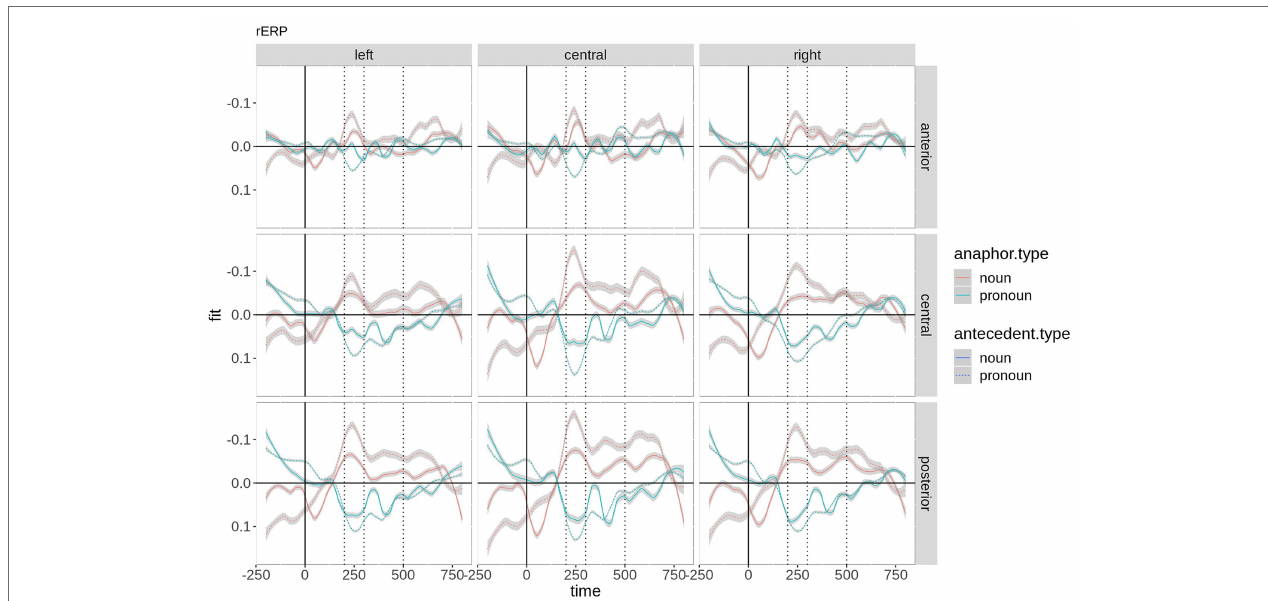
FIGURE 3 | Time course of the beta coefficients of the critical predictors and their interaction by ROI. For plotting purposes, the continuous topographic variables were grouped into ROIs based on two-dimensional coordinates. Shaded areas represent 83% confidence intervals (an approximation to the traditional 0.05 level of significance for visualization purposes).